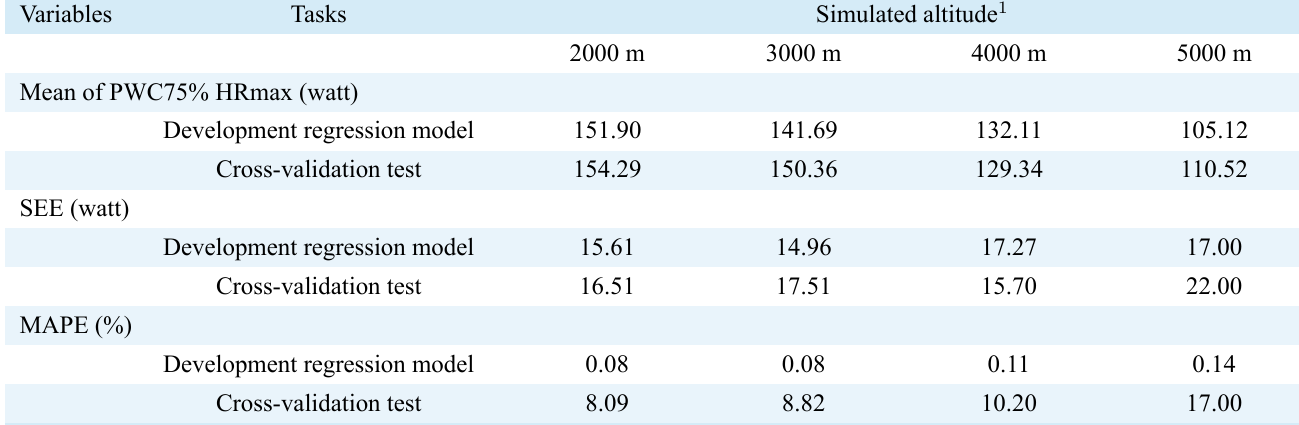
TABLE 10. Standard error of estimation and the mean absolute percentage error for each regression model.